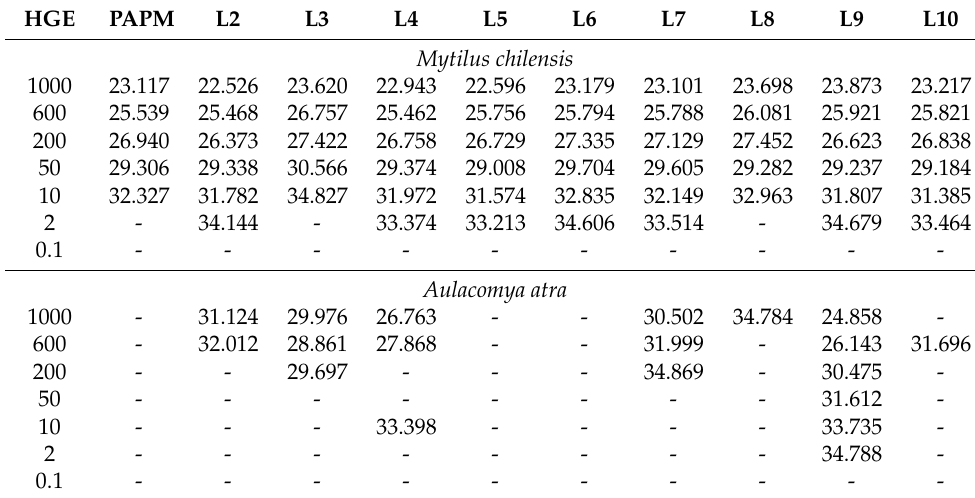
Table 5. Cq values in LOD preliminary screening in 10 SNPs in Mytilus chilensis and Aulacomya atra .